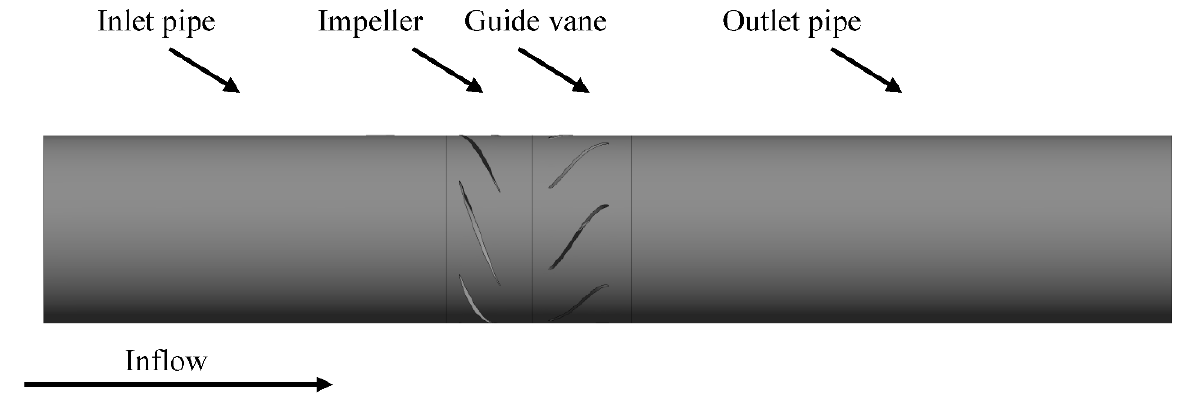
Figure 2. Computational domain.